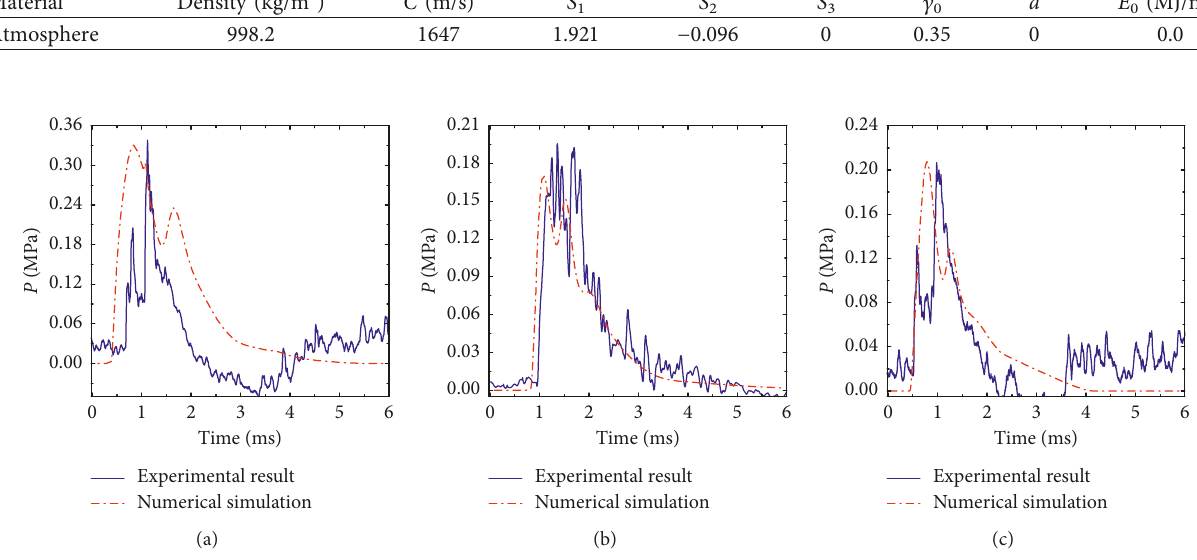
Figure 4: The comparison between experiment and numerical simulation. (a) Gauge A. (b) Gauge B. (c) Gauge